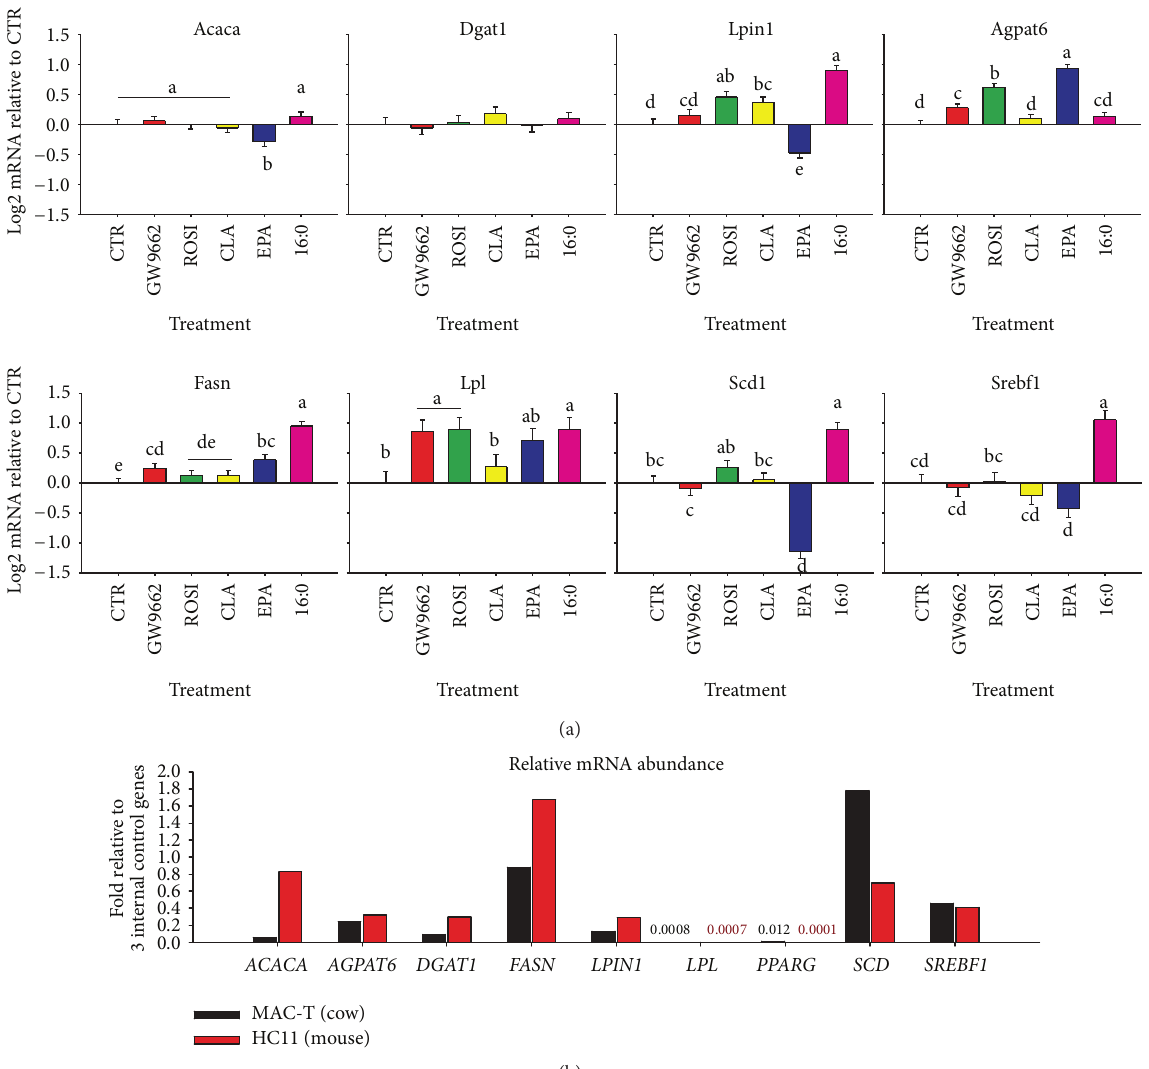
Figure 3: Effect of PPAR 𝛾 activation on genes coding for proteins involved in milk fat synthesis in mouse mammary epithelial cells HC11. The experiment was performed with the purpose to test the effects of 50 𝜇 M of the PPAR 𝛾 activator rosiglitazone, the PPAR 𝛾 inhibitor GW9662, or 100 𝜇 M of several long-chain fatty acids ( trans -10, cis 12-conjugated linoleic acid (CLA), eicosapentaenoic acid (EPA), or palmitate (16:0)) for 12 hours in HC11 cells and compare the data with results using the same experimental design (except the GW9662 treatment) in MAC- T cells [26]. All the procedures with few modifications were as previously described [26]. The RNA was extracted and qPCR performed for several genes known to be involved in milk fat synthesis and significantly upregulated by rosiglitazone in MAC-T cells and the same 3 internal control genes used [26]. In (a), the effect of treatments on HC11 cell is reported. For that experiment, the qPCR data were calculated as fold change relative to control and log2 transformed prior statistical analysis using Proc GLM of SAS with treatment as main effect and replicate as random. Dissimilar letters denote significant differences between treatments ( 𝑃 < 0.05 ). In (b), a comparison in mRNA abundance between measured genes in the control group of HC11 and MAC-T cells is presented. The relative mRNA abundance was calculated as previously described [26] but as fold difference relative to the geometric mean of the median Ct values of the 3 internal control genes instead as % relative abundance. The same analysis was performed for the MAC-T cells using data previously published [26]. The PPARG was detectable only for few samples in HC11 cells and LPL was barely detectable in both HC11 and MAC-T